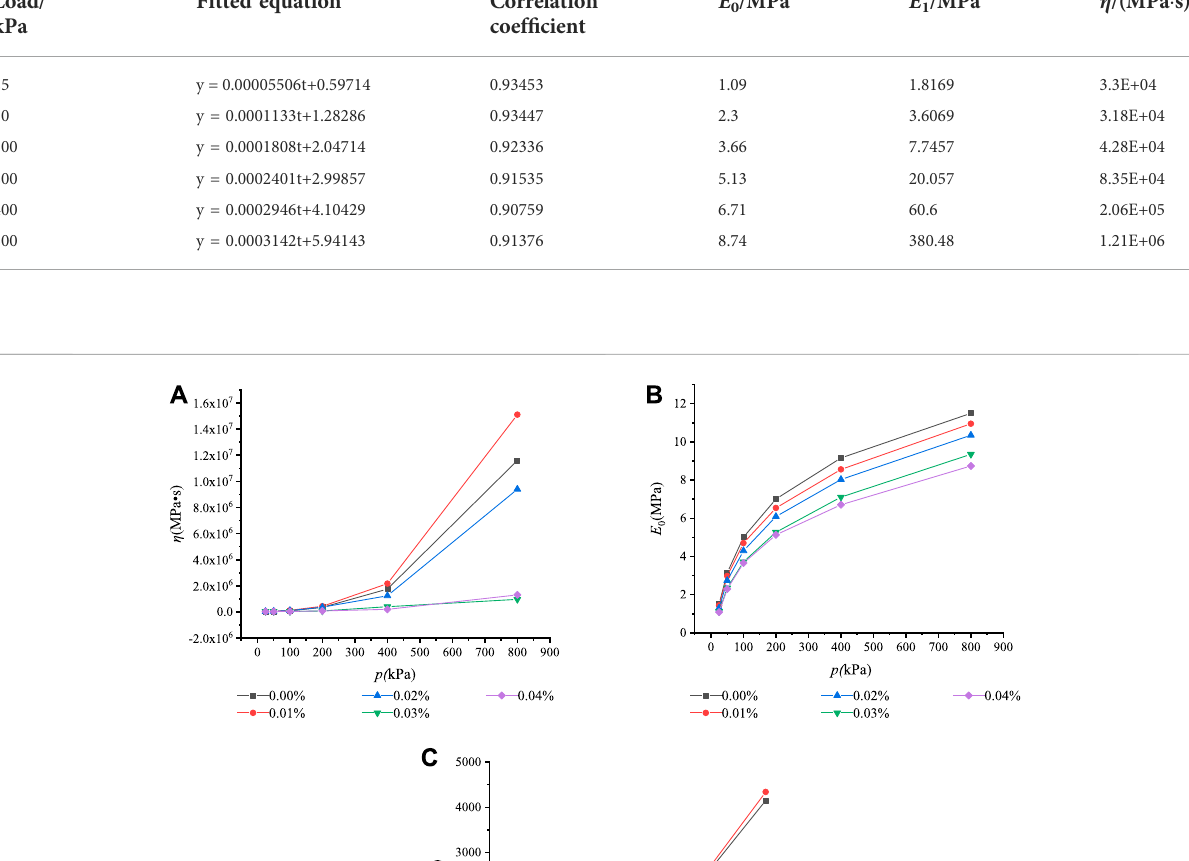
TABLE 6 Rheological model fi tting results and parameters of the samples when the ratio of bio-enzyme was 0.04%. Load/ kPa